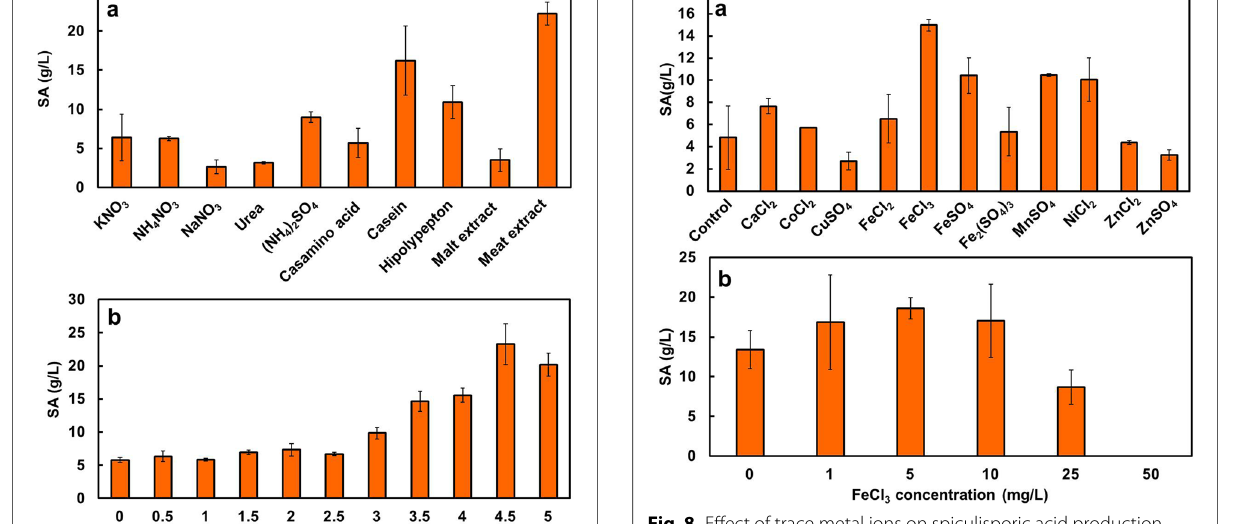
Fig. 8 Effect of trace metal ions on spiculisporic acid production by T. trachyspermus NBRC 32238. a Comparison of spiculisporic acid production with various metal compounds. b Spiculisporic acid production with FeCl 3 at concentrations of 0–50 g/L. Cultivation was carried out with 100 g/L glucose at 28 °C for 7 days. Error bars indicate standard deviations from three independent